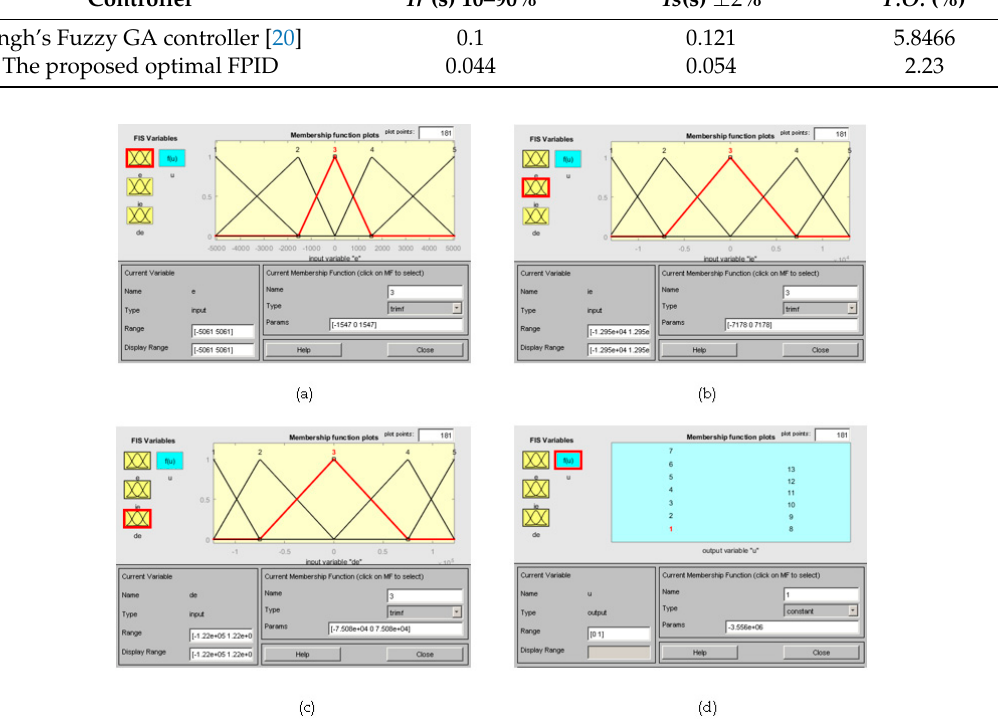
(cid:82) . e ( t ) ; ( c ) e ( t ) ; and ( d ) u ( t ) in Matlab.